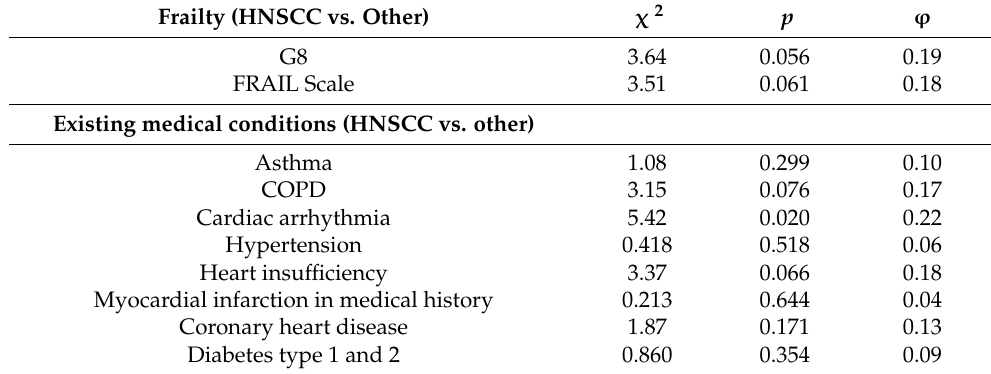
Table 5. χ 2 test for frailty and existing medical conditions between HNSCC and other ENT diagnoses. Frailty (HNSCC vs. Other) χ 2 p